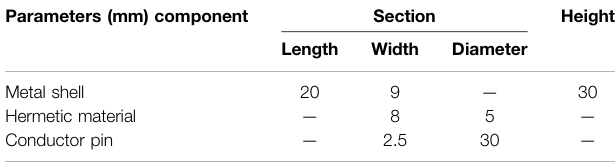
TABLE 2 | Geometrical parameters of the designed model.